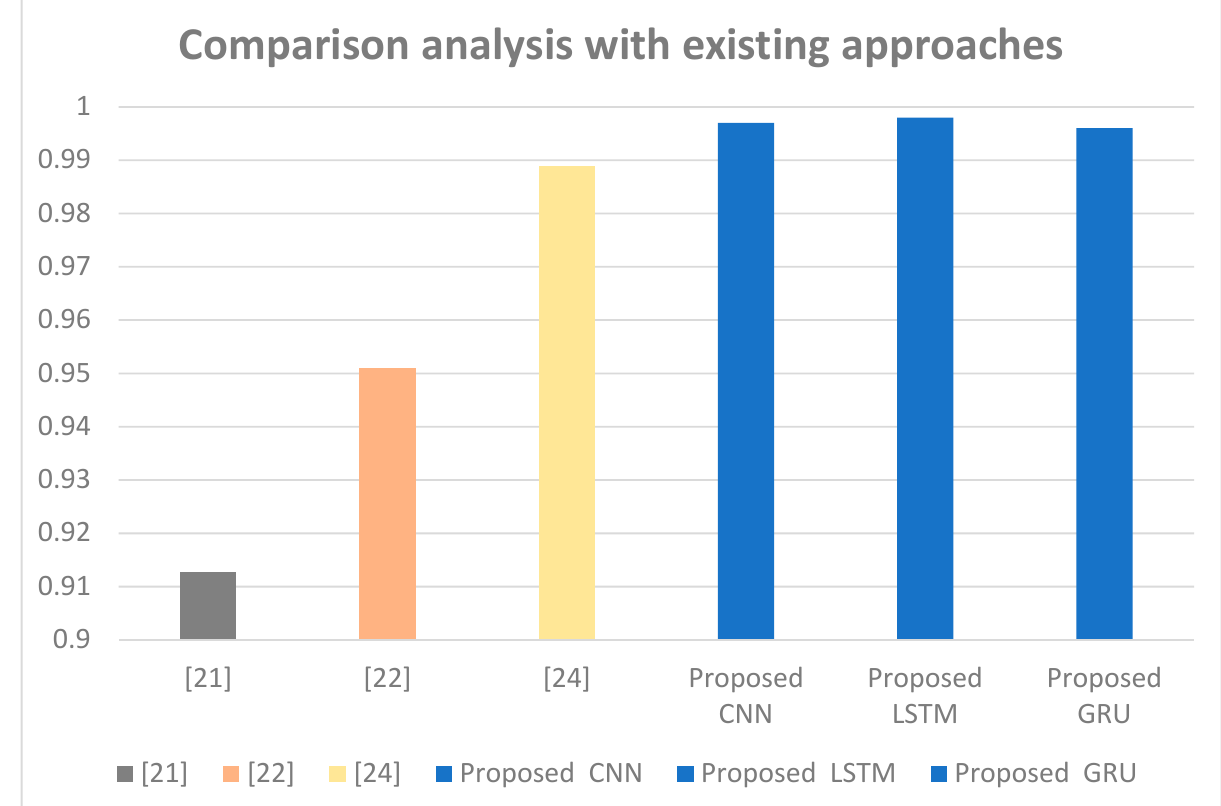
Figure 4. Accuracy comparison with existing approaches.